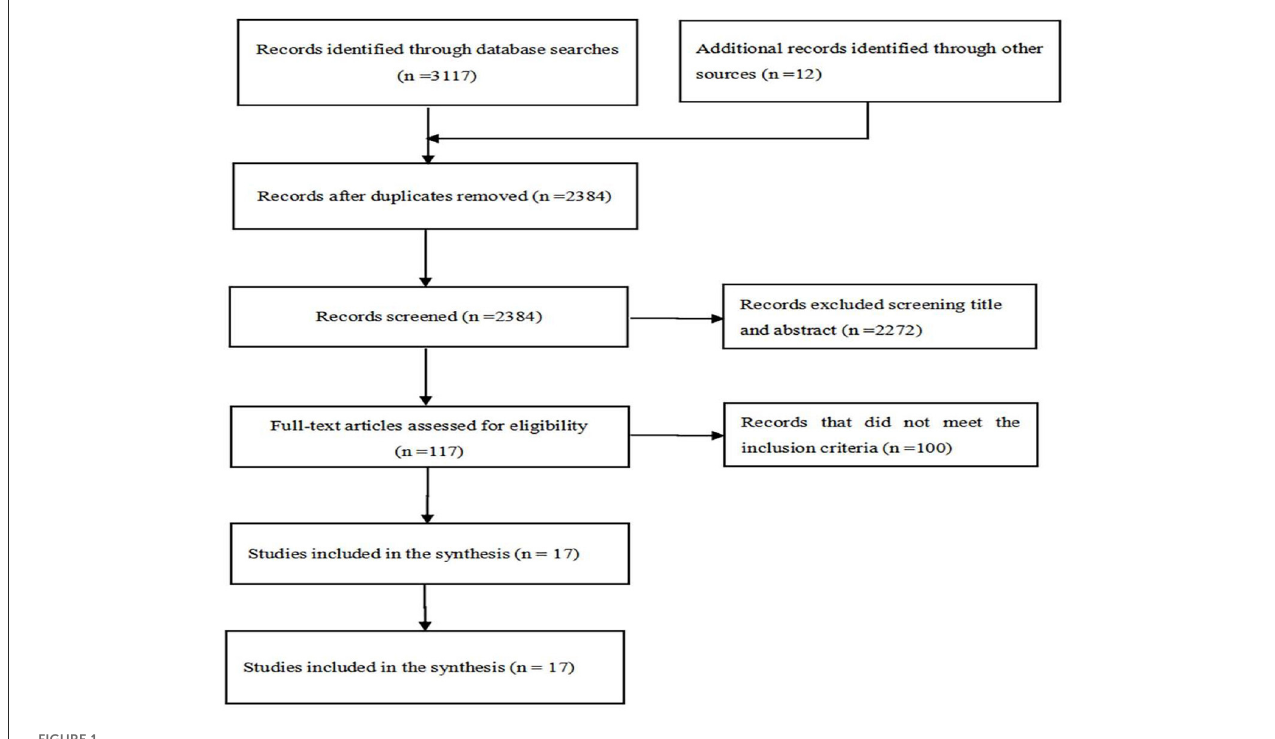
FIGURE1 PRISMA flow diagram.